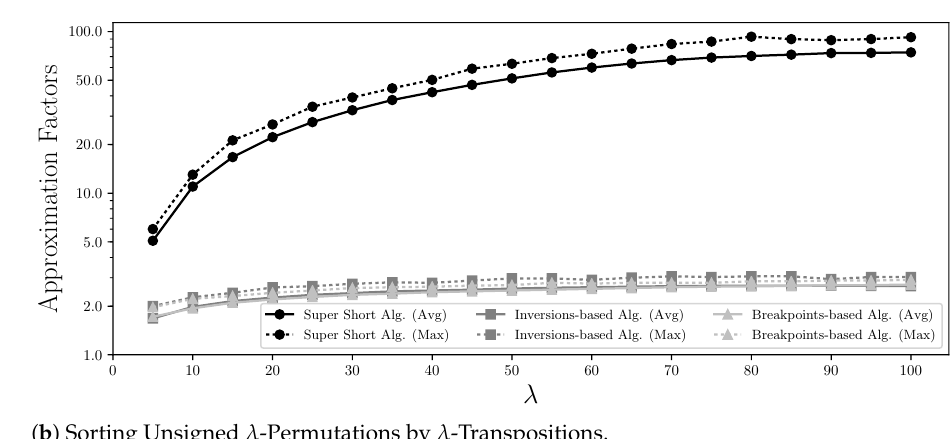
Inversions-based Alg. (Avg) Inversions-based Alg. (Max)